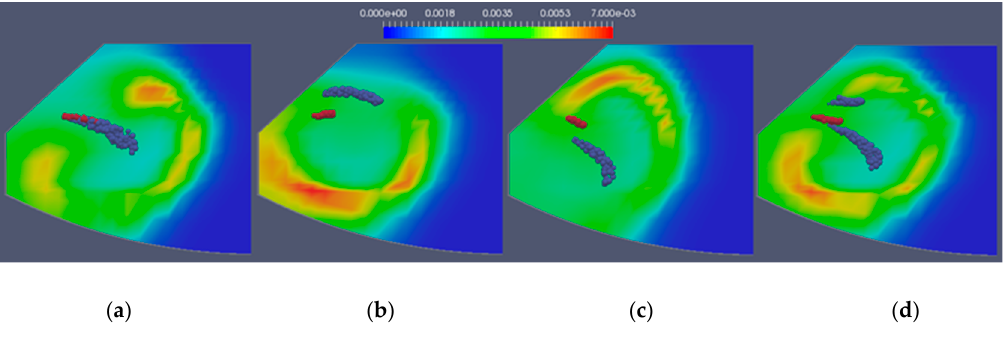
Figure 8. Local NO concentration for di ff erent water injection locations, crank angle (CA) = 15 ◦ . ( a ) same location of the water and fuel nozzle; ( b ) water nozzle over the fuel nozzle; ( c ) water nozzle under the fuel nozzle; ( d ) case with a water nozzle over and under the fuel